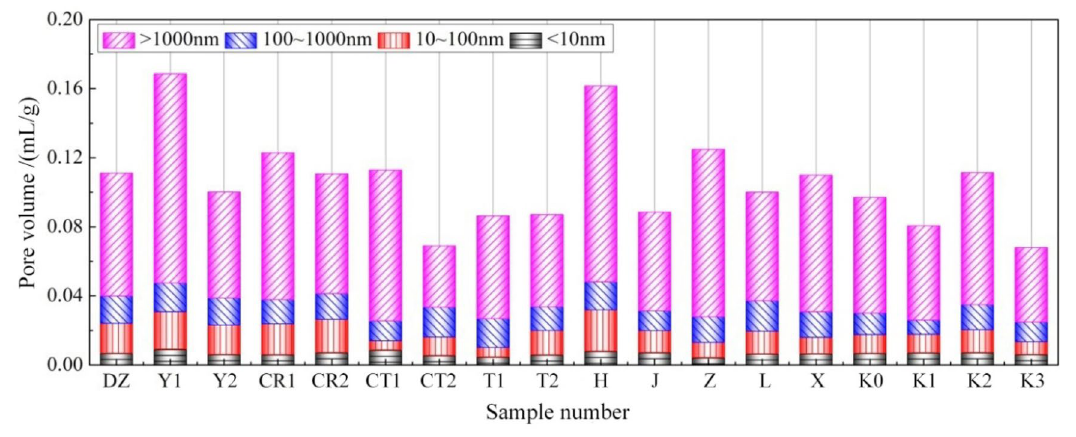
Figure 11. Pore volume distribution.